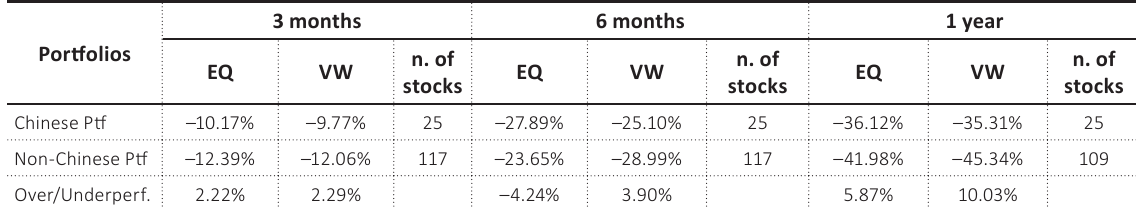
Table 8. Buy-and-hold